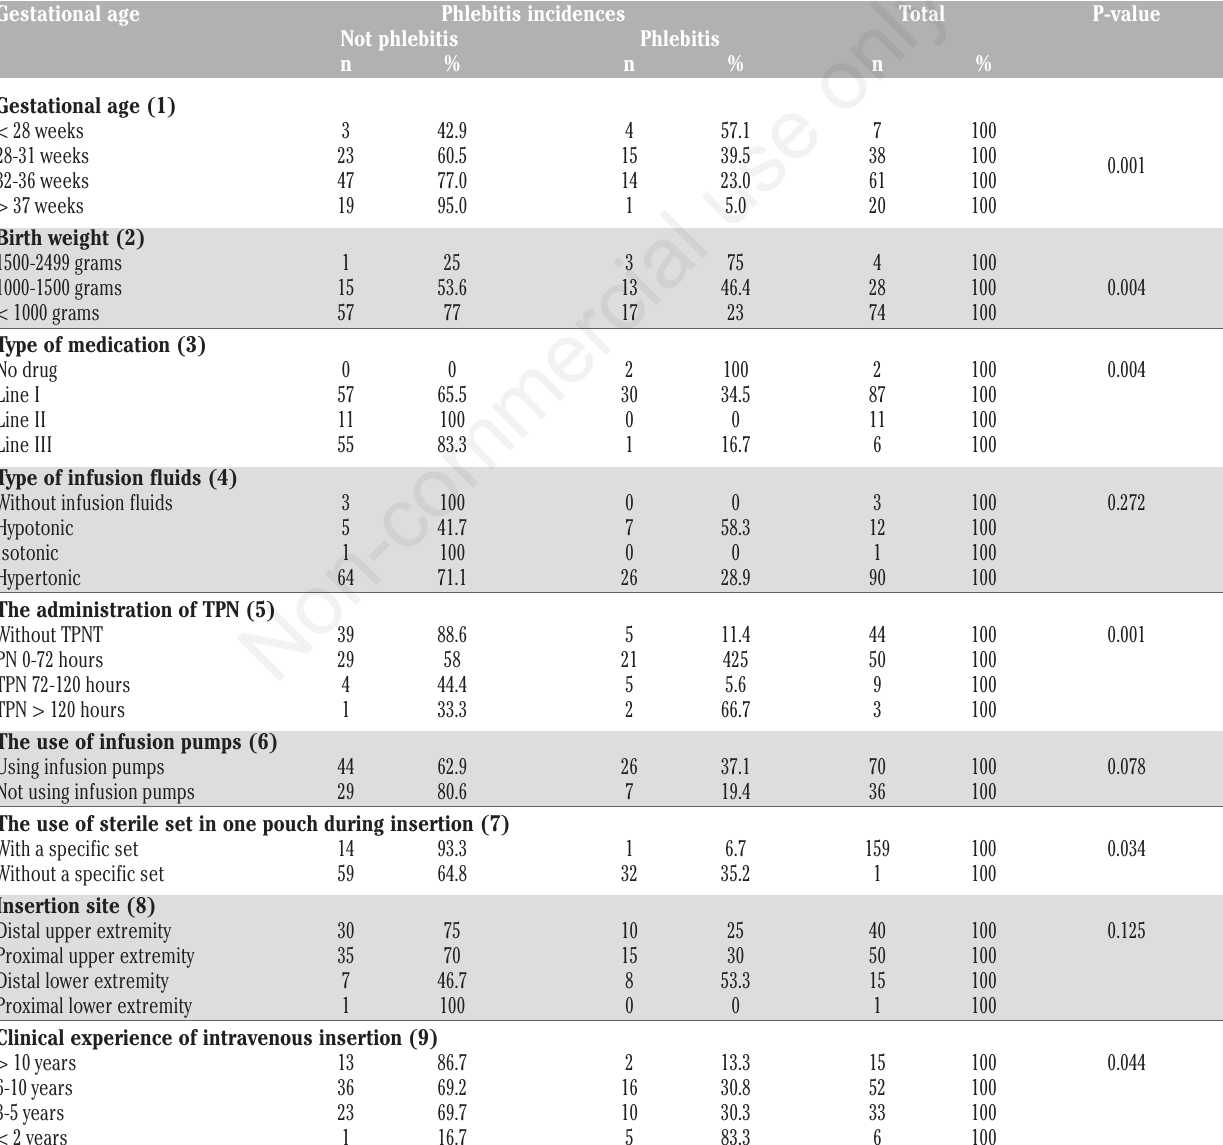
Table 1. Distribution of respondents based on variables correlation with phlebitis incidences (n=106). Gestational